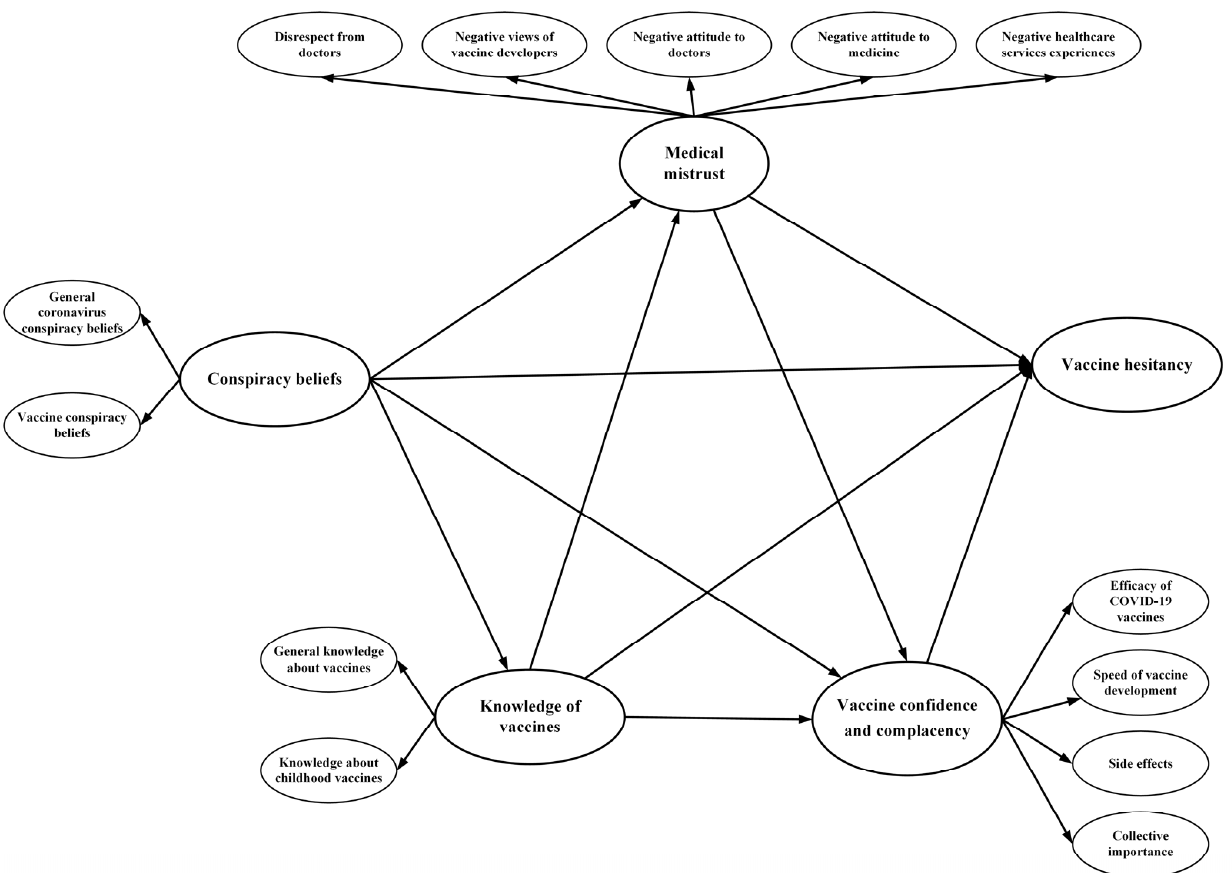
Figure 1. Hypothesized pathways from conspiracy beliefs to vaccine hesitancy of COVID-19 vaccines in the conceptual model.